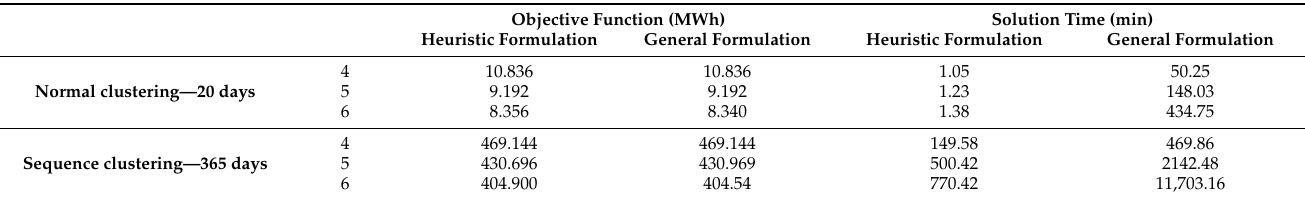
Table 2. Computational performance of heuristic and full-scale